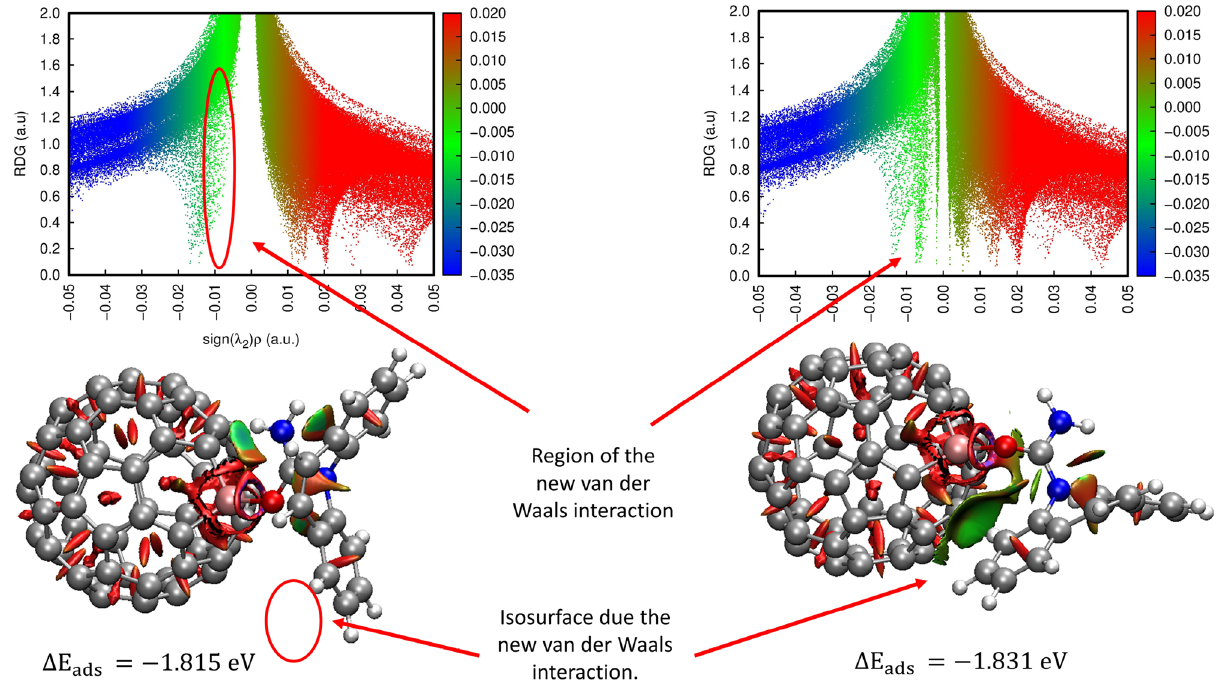
Figure 5. RDG isosurfaces and scatter graphs for the two local minima configuration of C 59 Ga-CBZ (II). On the left, a local minimal structure presents the lack of a vdW interaction. On the right, after a new scan calculation, the missed vdW interaction appears. This new vdW interactions helps in a slight increase of the (cid:31) E ads regions represent strong attractive effects. The RDG isosurfaces and scatter graph for all C 59 X-CBZ complexes are detailed in Tables S8 and S9.